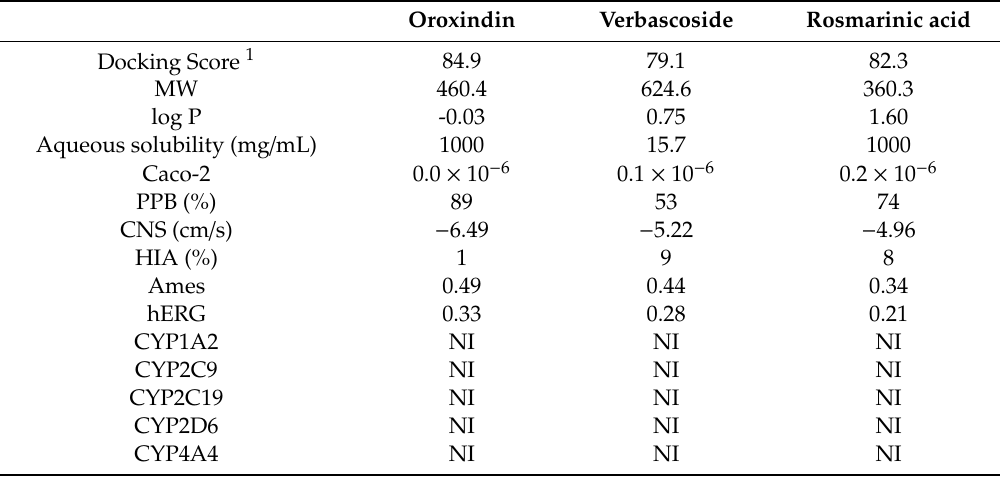
Table 1. Docking scores and drug-like properties of the